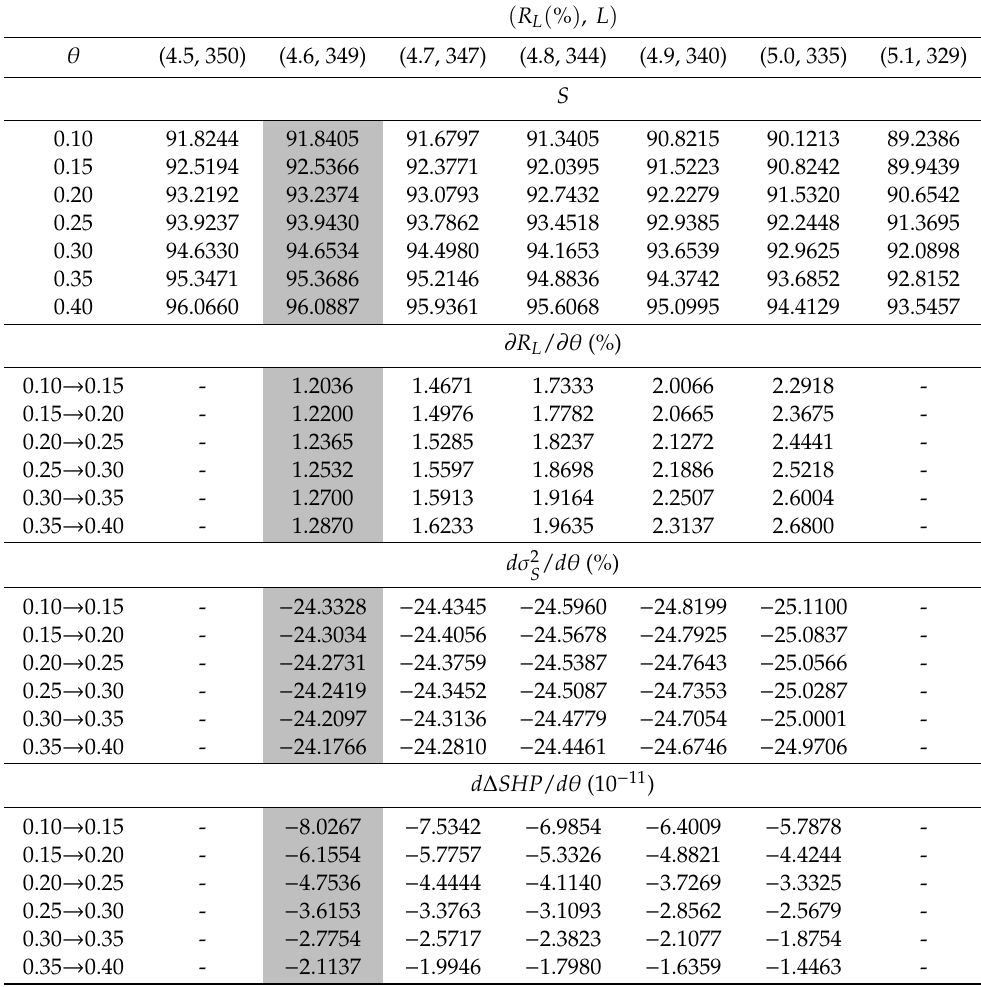
Table 5. E ff ects of government capital injection on domestic loan rate, equity risk, and diversification e ffi ciency.